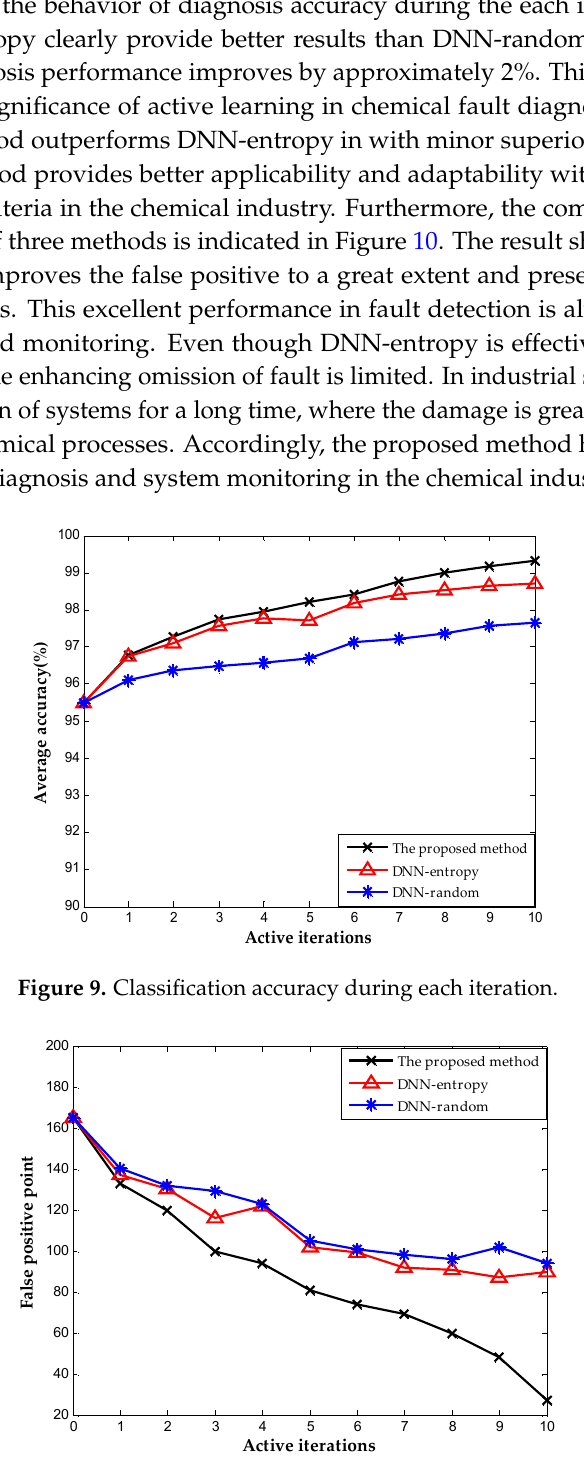
Figure 10. The number of false-positive point during each iteration .